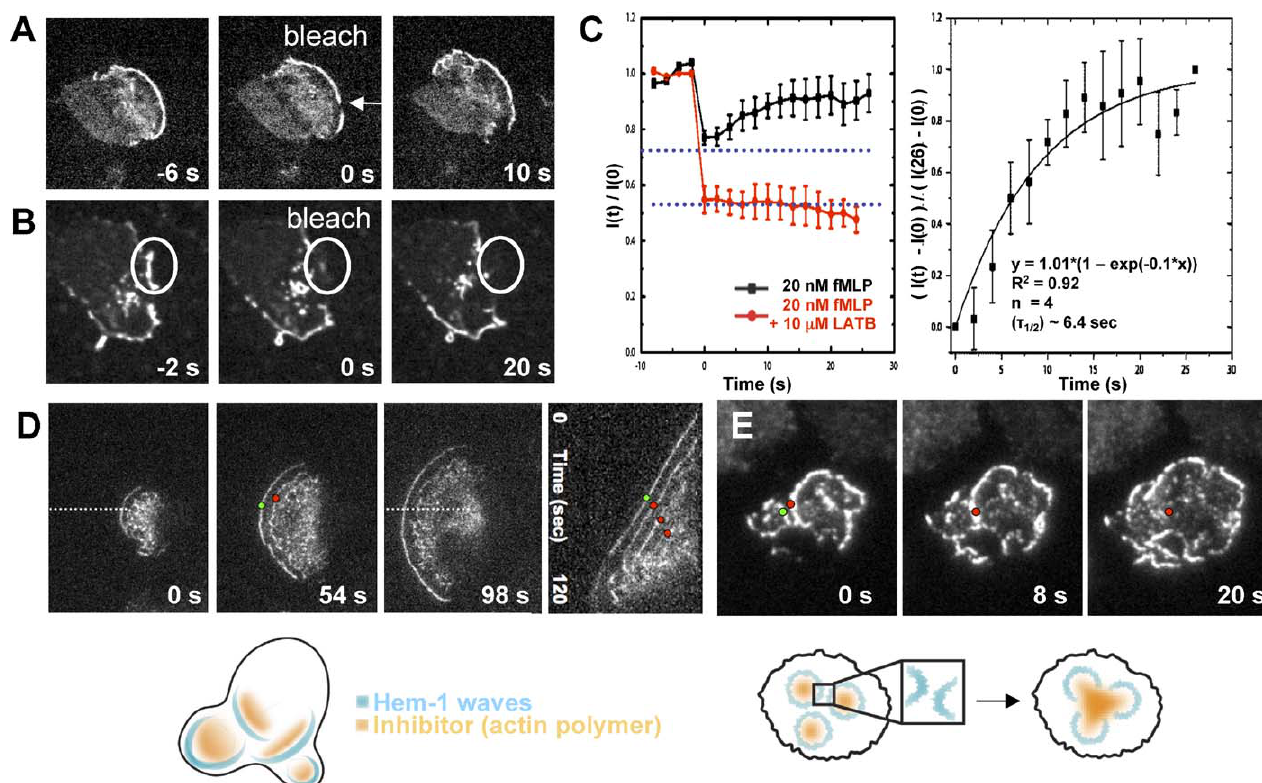
Figure 3. Hem-1 Waves Result from Propagated Recruitment and Release of Hem-1, Not a Moving Front of Translocated Protein (A) Control Hem-1-YFP–expressing cells (pre-polarized in uniform chemoattractant) rapidly recover fluorescence intensity following photobleaching, indicating rapid exchange of membrane-bound Hem-1 with the cytosolic pool (Video S11). (B) Depolymerization of the actin cytoskeleton with latrunculin inhibits the recovery of Hem-1-YFP fluorescence intensity following photobleaching indicating a lack of exchange of Hem-1 in the absence of actin polymers. Cells were first stimulated with uniform fMLP, treated with latrunculin until the intensity of membrane-bound Hem-1 stabilized (greater than 3 min), and then a 1–2- l m radius spot was photobleached. (C) Quantitation of Hem-1-YFP intensity following photobleaching of control (black, n ¼ 4 cells) or latrunculin-treated cells (red, n ¼ 5 cells). The right panel represents fit of control cell Hem-1 FRAP data (half-life on membrane ¼ 6.4 s, obtained from four cells). (D) Cell with single dominant peripheral Hem-1 wave and multiple interior waves shows a clear refractory region between the most peripheral Hem-1 wave (green dot) and the next wave (red dot)—see Video S12. Final panel is kymograph of the same cell. Vertical axis of the kymograph is time and horizontal axis is spatial position corresponding to dotted line in first and third panels. The kymograph shows several sets of waves (leading edge green dot, subsequent waves red dots) with clear gaps between them. The bottom schematic indicates our working model— Hem-1 waves (blue) deposit an inhibitor in their wake (orange) that transiently inhibits Hem-1 recruitment. We later present data that actin polymer represents a component of this inhibitor. (E) Annihilation of two colliding Hem-1 wavefronts (one green dot, one red dot at t ¼ 0) in single cell (Video S13). Waves collide at 8 s (red dot) and are both extinguished by 20 s (red dot). The bottom schematic indicates our interpretation of colliding waves. Hem-1 waves (blue) deposit an inhibitor in their wake (orange), leading to annihilation of colliding waves. This property could enable cells to focus wave propagation and actin polymerization toward the cell